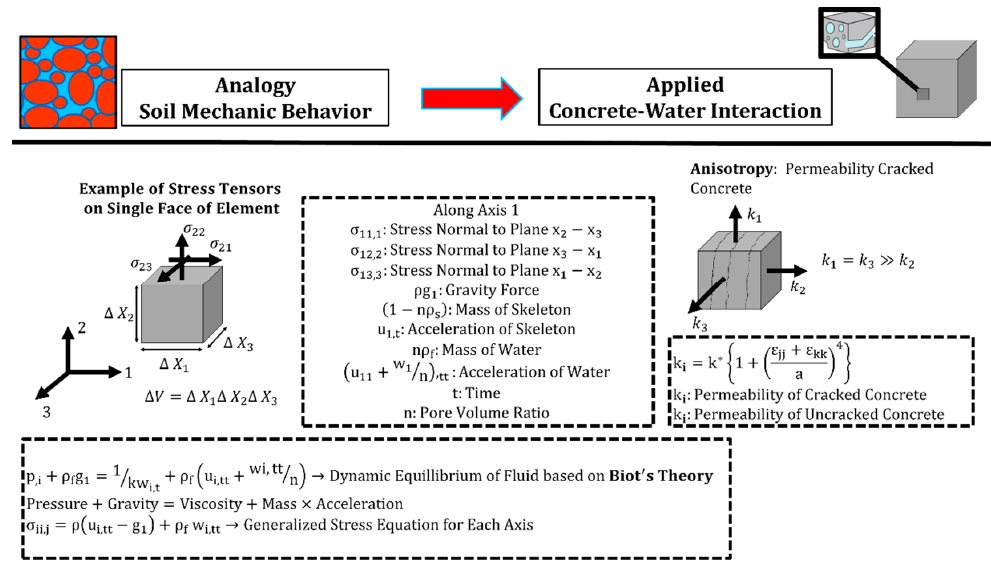
Figure 3. Constitutive laws of concrete–water interaction.